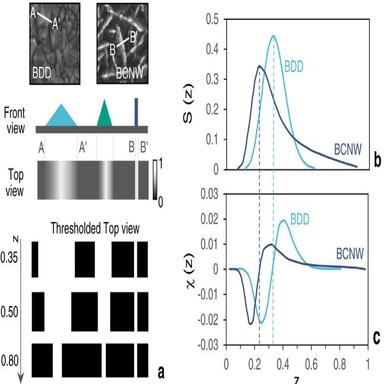
(a) Schematic explanation of the Mfs for two representative cases. Representation of the (b) Minkowski surface and (c) Minkowski connectivity functions.